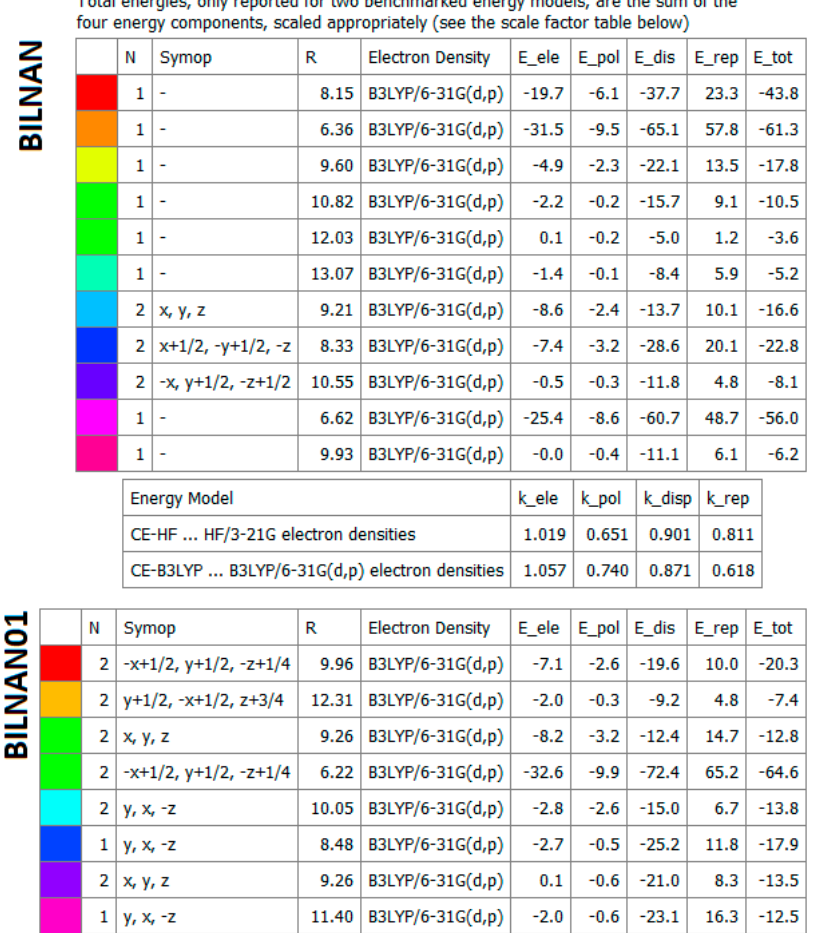
Figure 20. Interaction energies of the molecular pairs related to energy frameworks of DKP perindopril structures (Scale factors for benchmarked energy models). Pharmaceuticals 2020 , 13 , x FOR PEER REVIEW